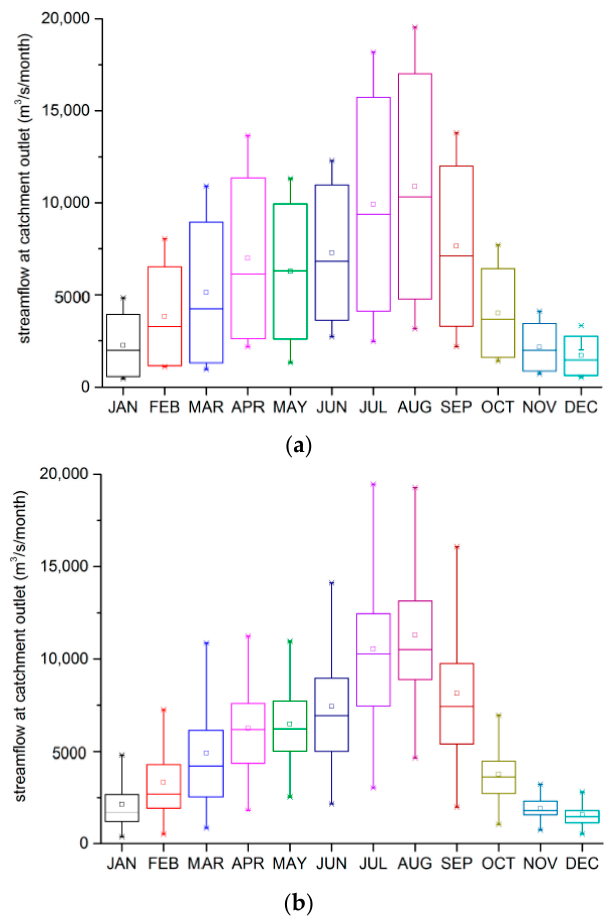
Figure 10. Illustration of the box plot for monthly flow simulation results driven by representative concentration pathways (RCP) rainfall in the XAJ model ( a : RCP4.5; b : RCP8.5).